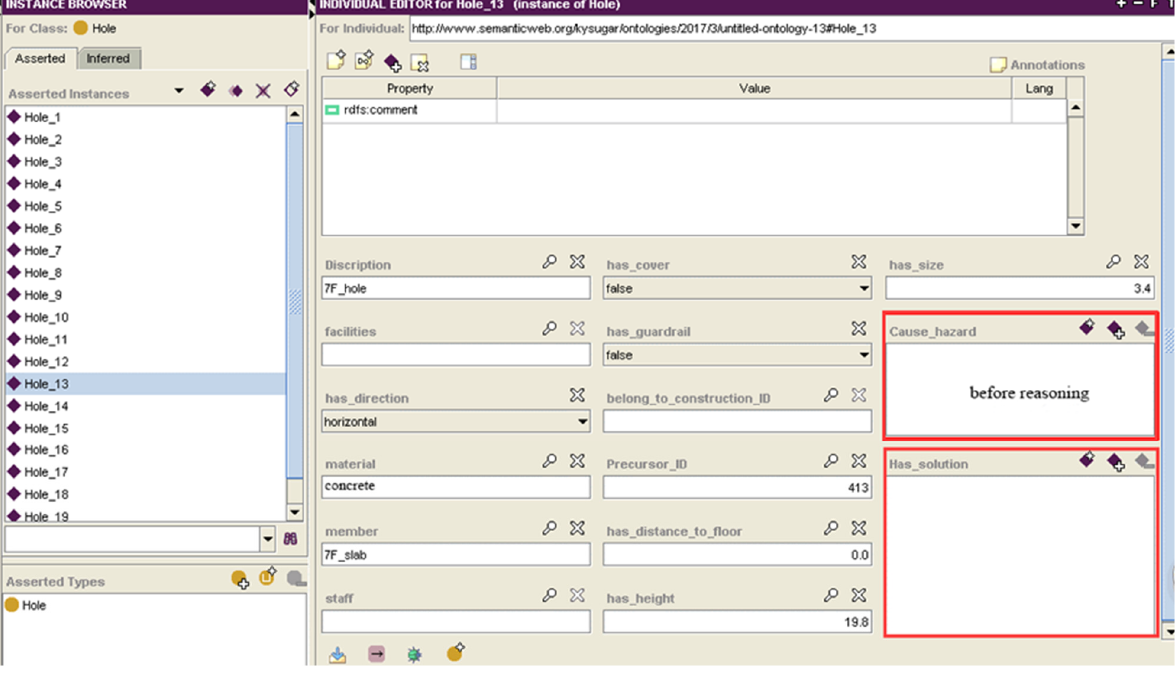
Figure 19. Extraction of the top floor stair opening information to the ontology instance.